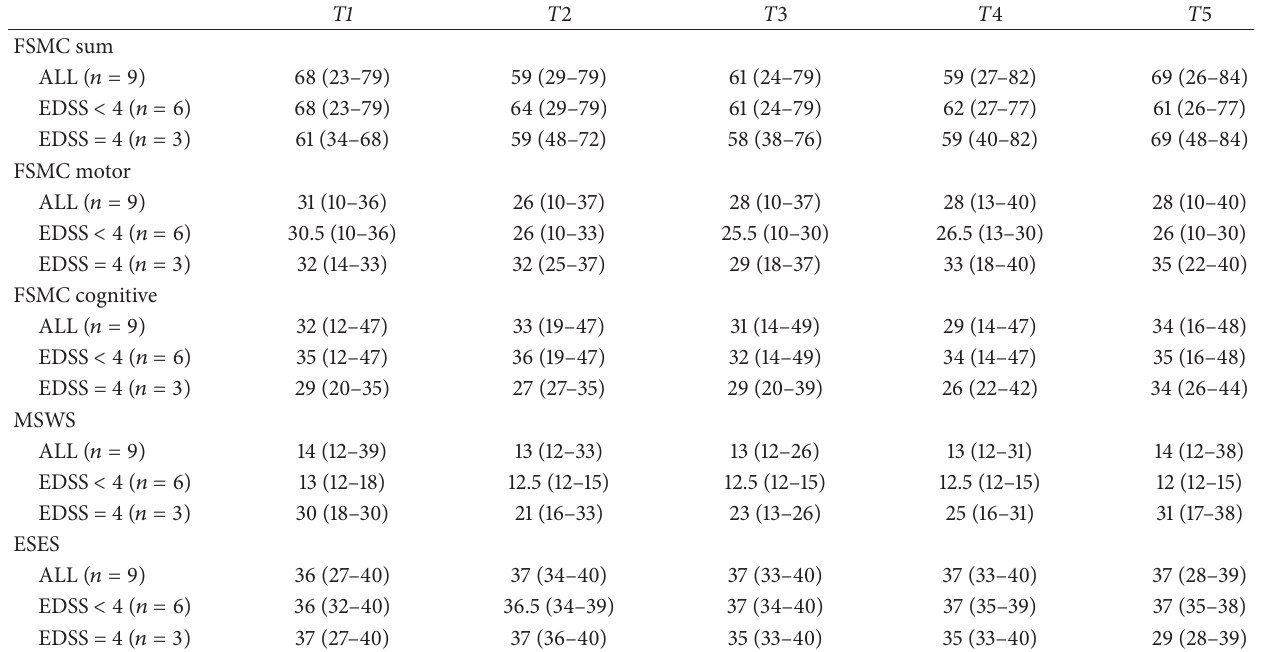
Table 3: FSMC, ESES, MSWS 12, and brief IPQ, median values (range) and stratified by EDSS 4.